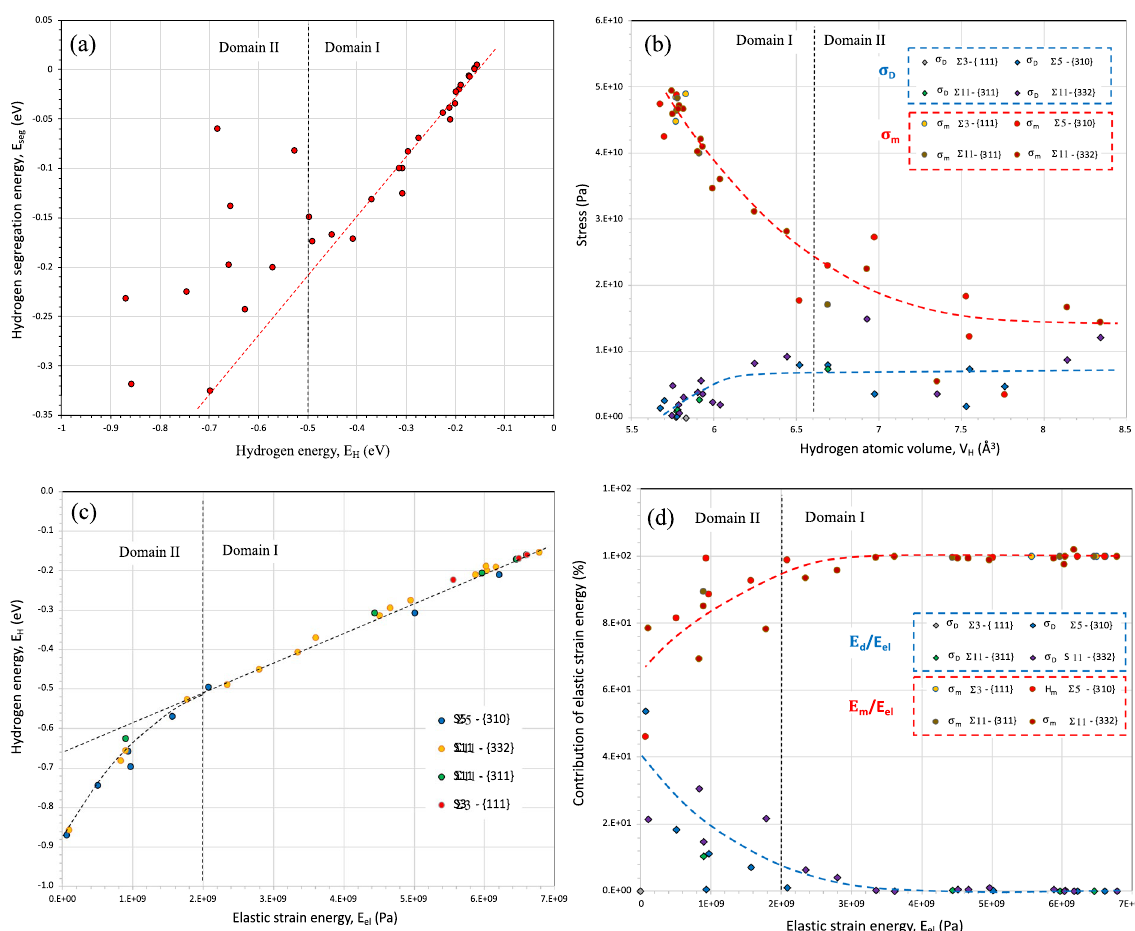
Figure 4. ( a ) Hydrogen segregation energy E seg versus hydrogen energy E H . ( b ) Hydrostatic σ m and deviatoric stress σ D as a function of hydrogen atomic volume V H . ( c ) Hydrogen energy E H vs the elastic strain energy E el (per unit of volume) ( d ) Contributions to the hydrostatic, E H and deviatoric, E D parts of energy to the elastic strain energy E el